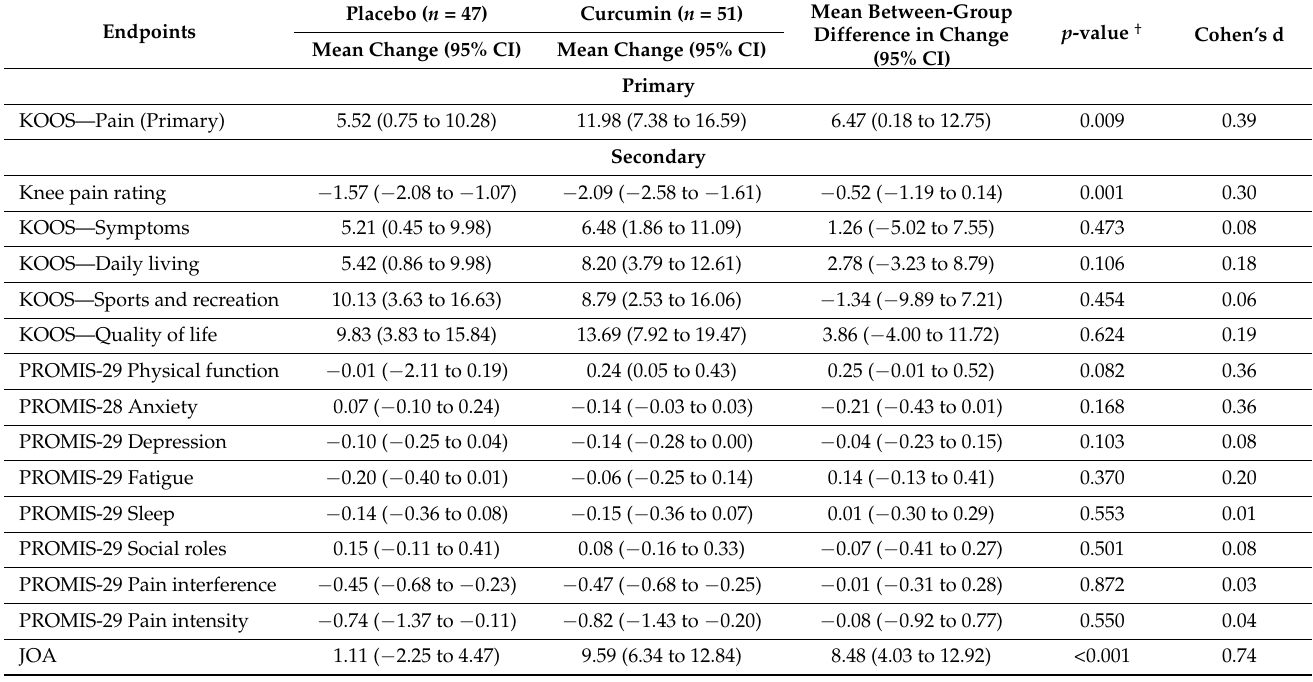
Table 2. Change in Outcome Measures from Baseline to Week